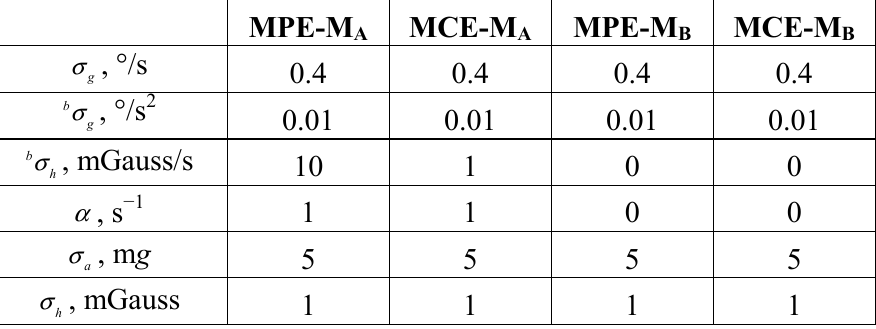
Table 1. EKF parameter setting (Monte Carlo